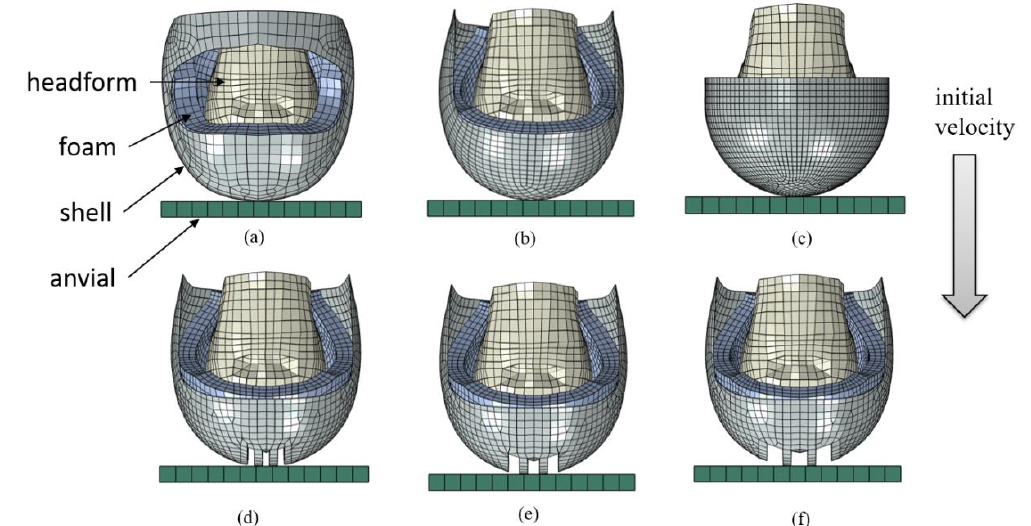
Figure 5. Finite element models of: ( a ) full-face; ( b ) open-face; ( c ) half-face; ( d ) prototype open-face helmet 8 mm design; ( e ) prototype open-face helmet 14 mm design; and ( f ) prototype open-face helmet 18 mm design helmets used in simulated impact tests.